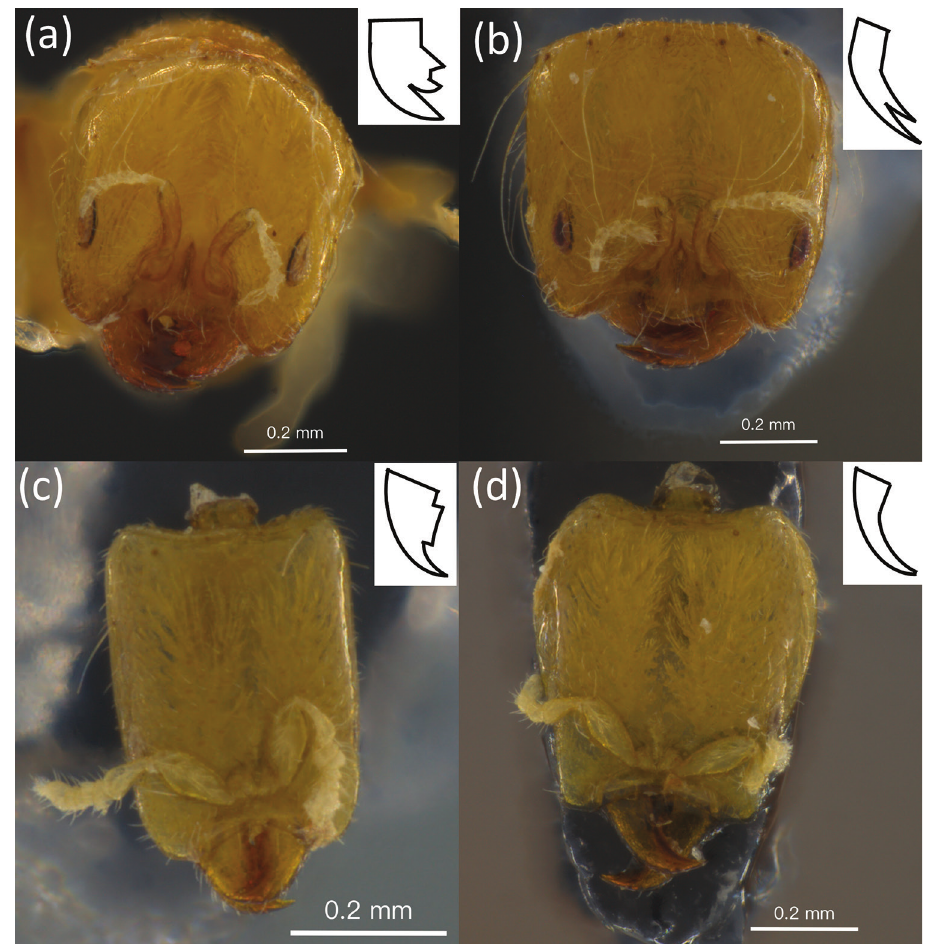
Figure 1. Frontal view of the males of the two studied species and mandible outline ( a ) a “typical” Philotrypesis male: rounded back of the head and broad mandibles ( b ) “atypical” Philotrypesis male: head more square and falcate mandibles ( c ) Sycorycteridea small male, rectangular head ( d ) Sycorycteridea large male, lantern-shaped